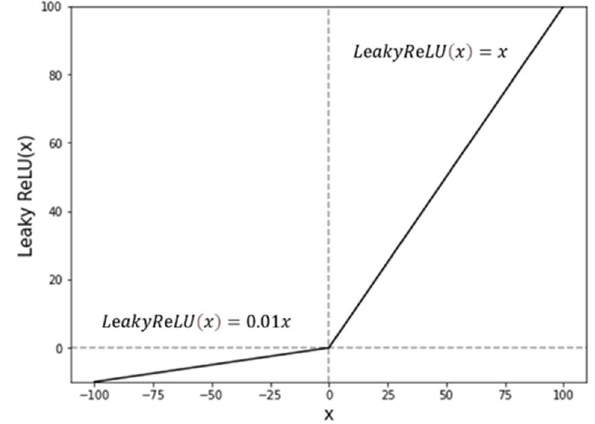
Figure 3. Leaky ReLU function.